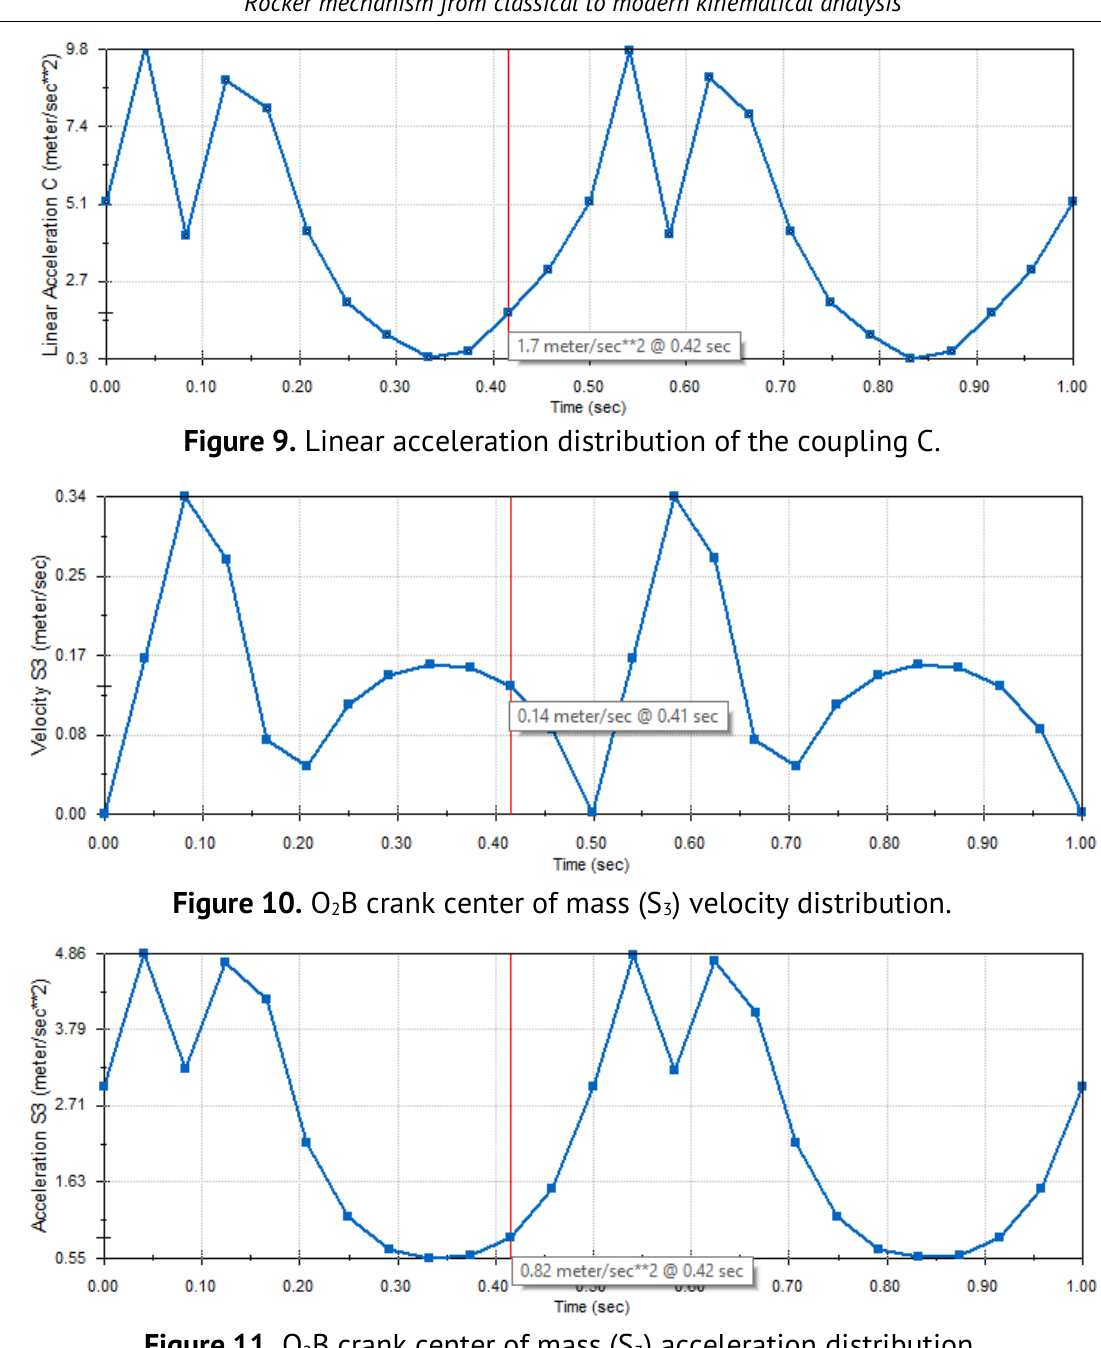
Figure 11. O B crank center of mass (S 2